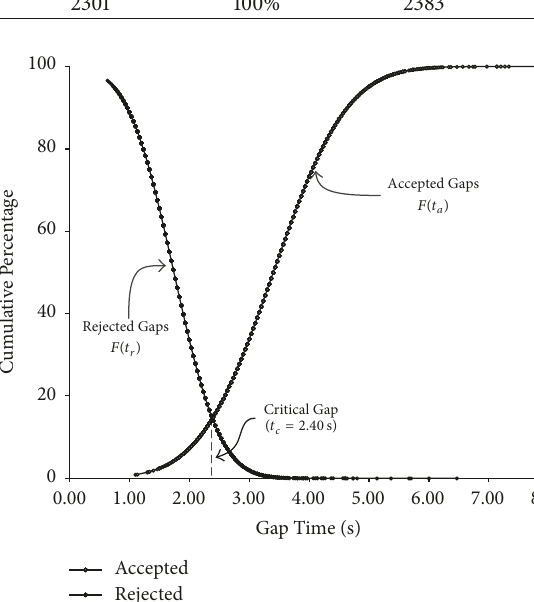
Figure 6: Overall critical